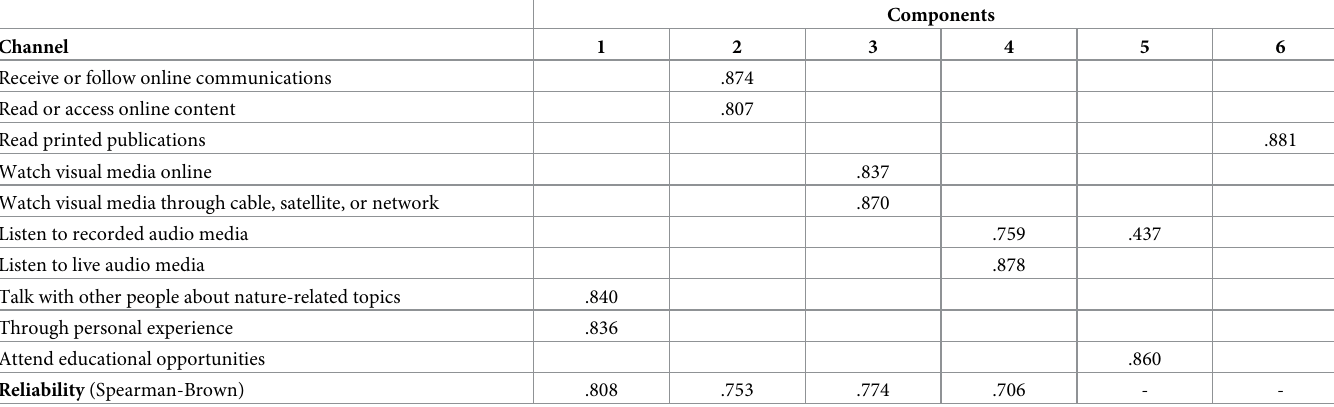
Table 4. Principle component analysis for channels of information.